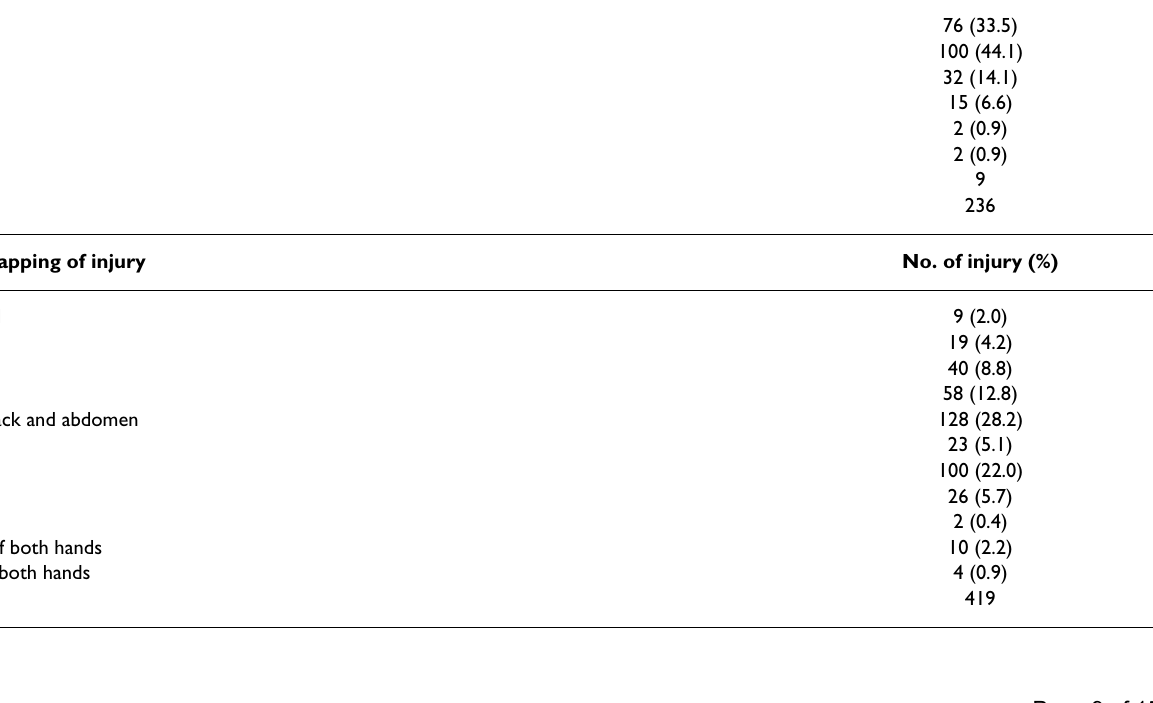
Table 4: Injury reporting by the study participants Numbers of reported injuries on the body